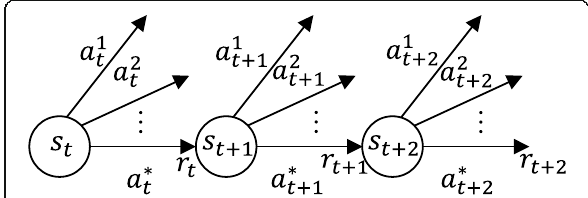
Fig. 7 General Q-learning mechanism. In general Q-learning mechanism, system moves to the next state using the optimal action in the corresponding state and selects the optimal action in the changed state and transitions to the next